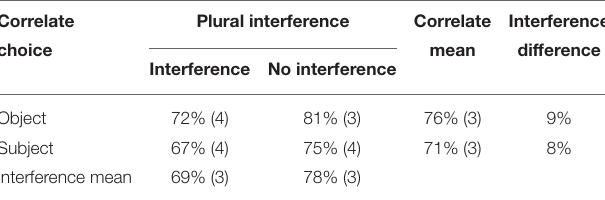
TABLE 3 | Experiment 1: responses by the percentage of cases in which the indefinite was selected as the correlate. Correlate